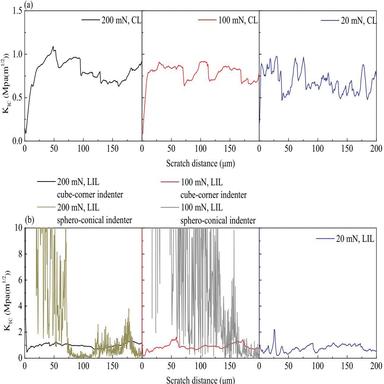
Stress intensity factor spectra of the HCP specimen tested by the cube-corner indenter with the maximum loads of 200, 100 and 20 mN under the (a) CL and (b) LIL routines (The spectra by the sphero-conical indenter at 200, 100 mN under the LIL routine were also plotted).